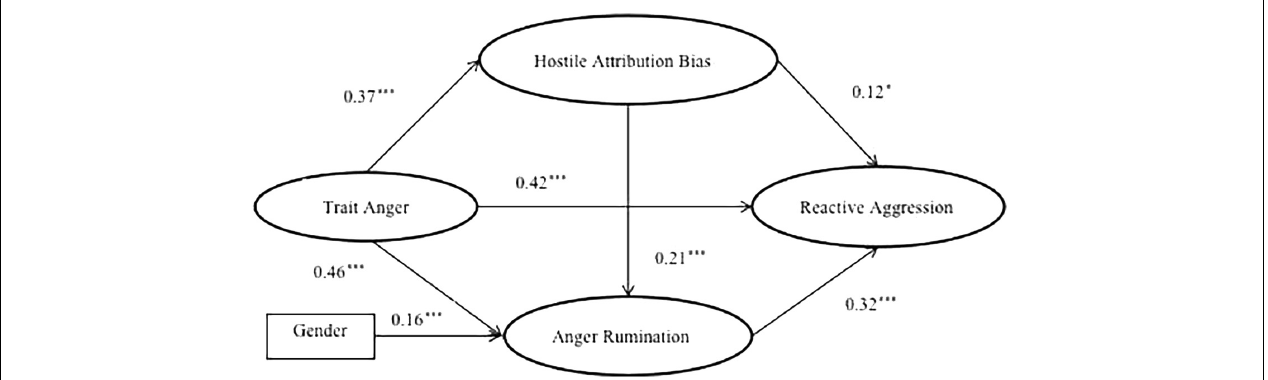
FIGURE 1 | The final model of chain mediation model. Only the significant standardized coefficients were showed in this final model. ∗ p < 0.05, ∗∗∗ p < 0.001.